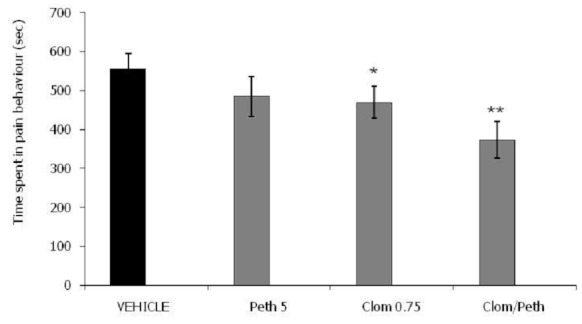
Combination of pethidine and clomipramine in the late phase of formalin test. Each group represents the mean ± SEM of 10 animals. *p<0.05, **p<0.01 when compared with the control value subsequent to ANOVA